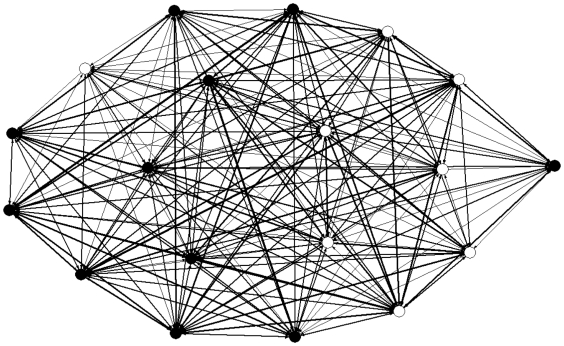
The master matrix (see Text S1) produced a directed and weighted network.Edge thickness reflects link weight (strength of relationship) and arrows show direction. Female participants are represented by closed circles, male participants by open circles.